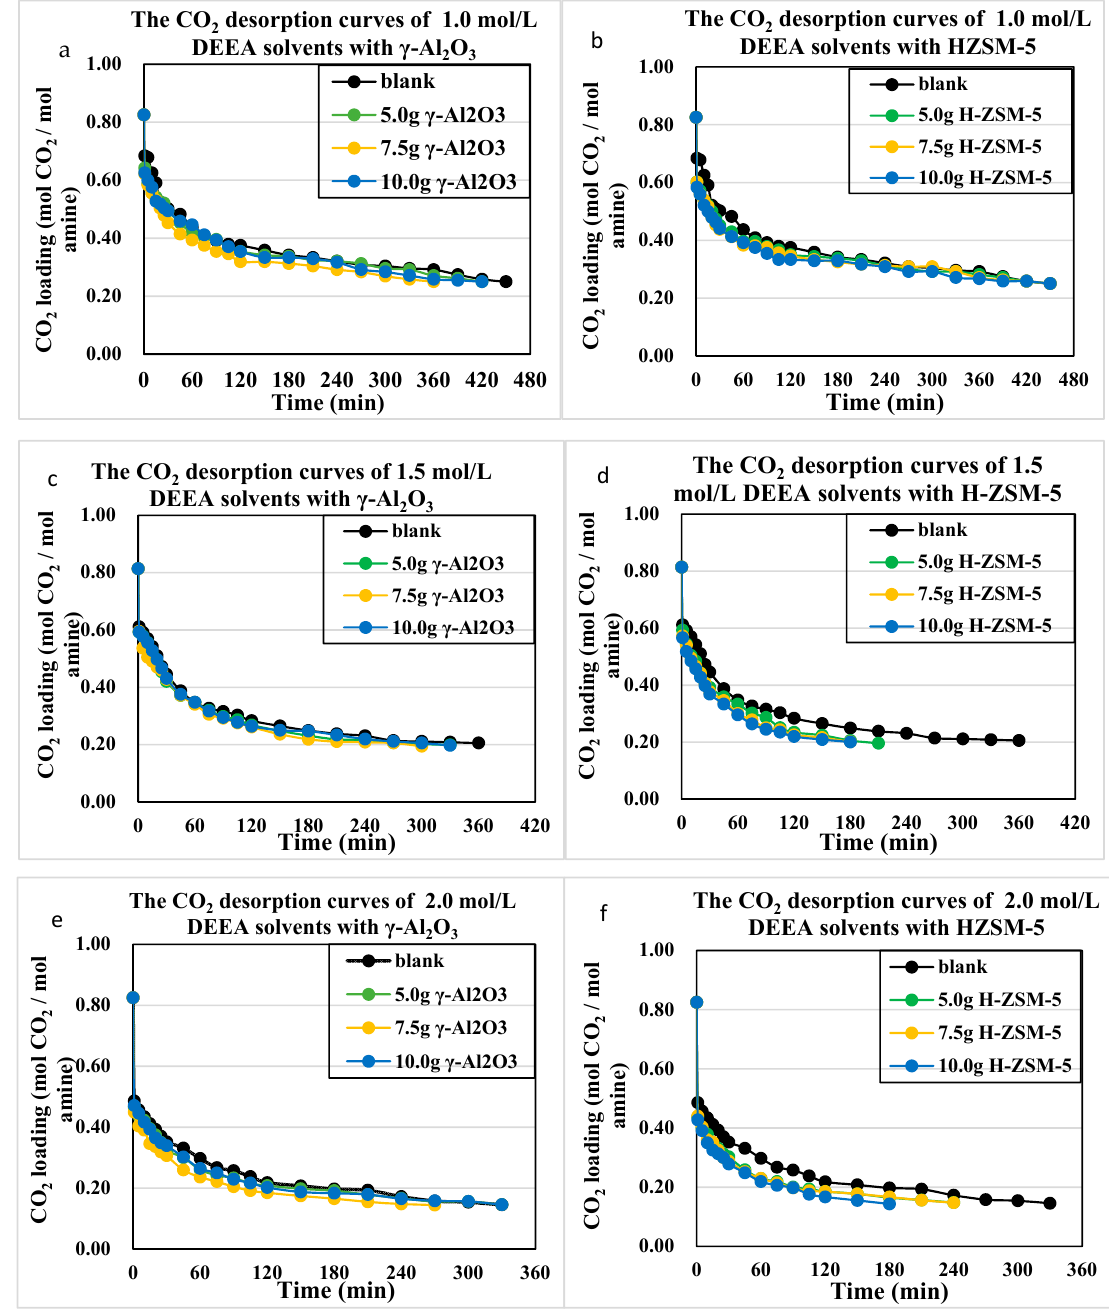
Figure 8. Catalytic CO 2 desorption curves of 1.0–2.0 mol/L DEEA solvents at 363 K and 1 atm, with 0–10 g γ -Al 2 O 3 and H-ZSM-5. ( a , b ) 1.0 mol/L with γ -Al 2 O 3 and HZSM-5; ( c , d ) 1.5 mol/L with γ -Al 2 O 3 and HZSM-5; ( e , f ) 2.0 mol/L with γ -Al 2 O 3 and HZSM-5.